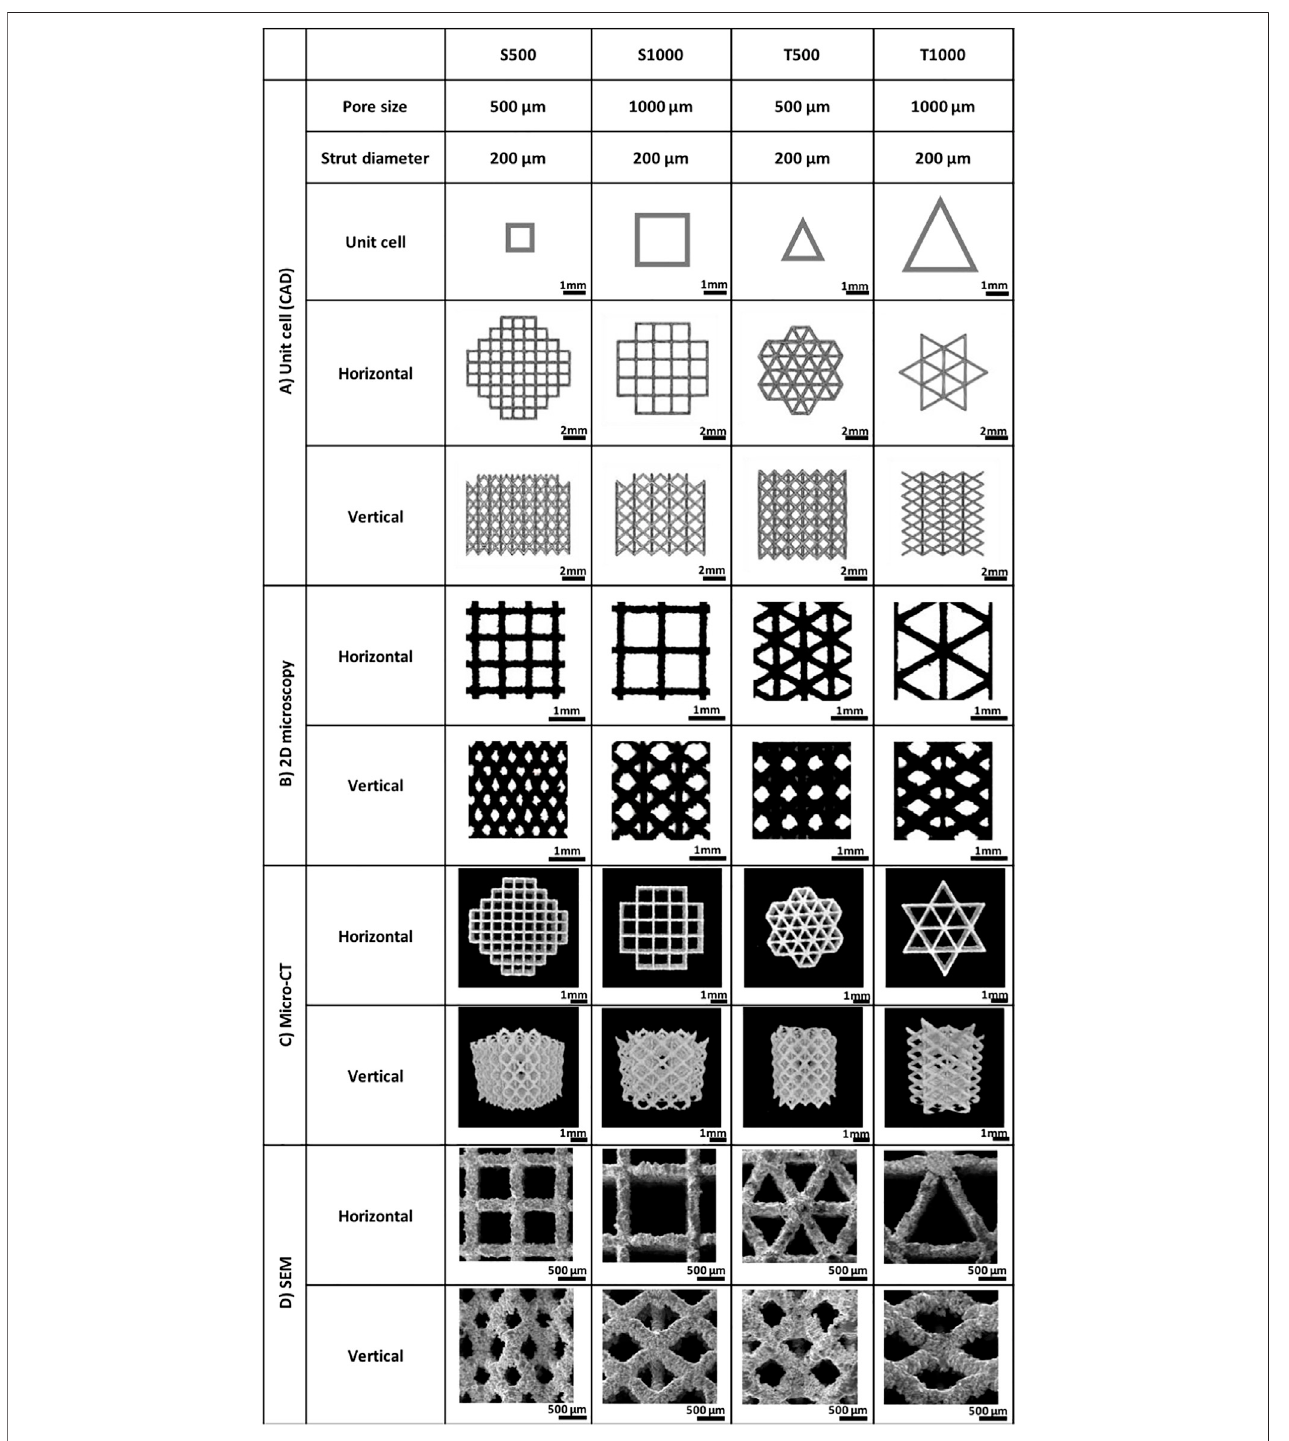
FIGURE 2 | Morphological analysis of the titanium scaffolds manufactured for the current study including (A) CAD unit cells, (B) 2D bright fi eld microscopy, (C) micro-CT scans and (D) SEM images. Scaffold designation = triangular (T) and square (S) and pore size (500 µm (500) and 1000 µm (1000)).